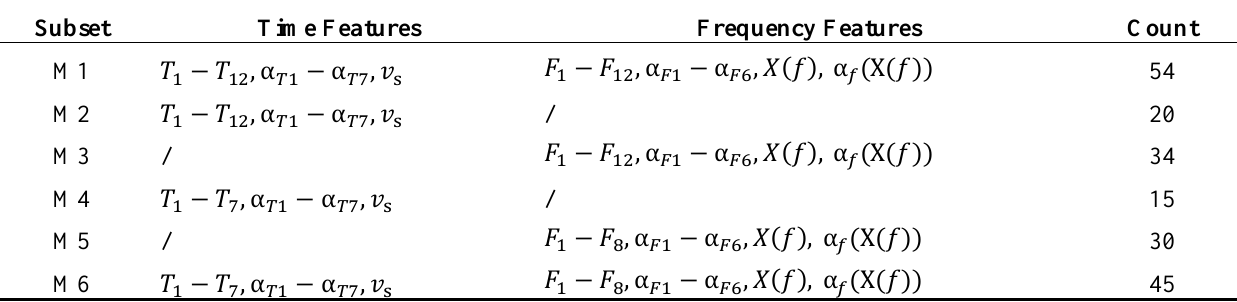
Table 2 . The feature subset summaries.